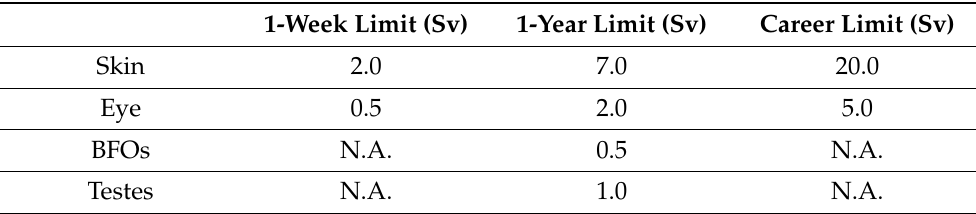
Table 5. JAXA limits for non-cancer effects